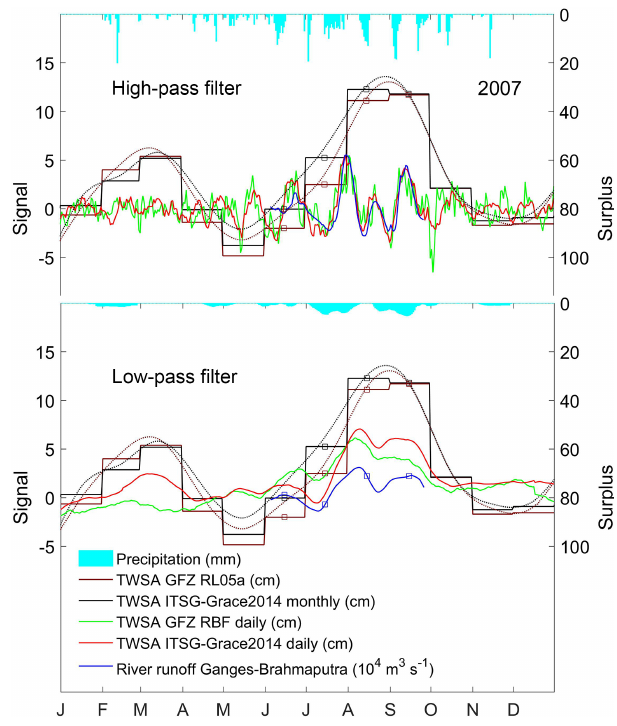
Figure 9. Daily and monthly area mean GRACE total water storage anomalies (TWSAs) and daily river runoff (left axis) together with the precipitation surplus (right axis) for the GBD in 2007. Key is as in Fig.